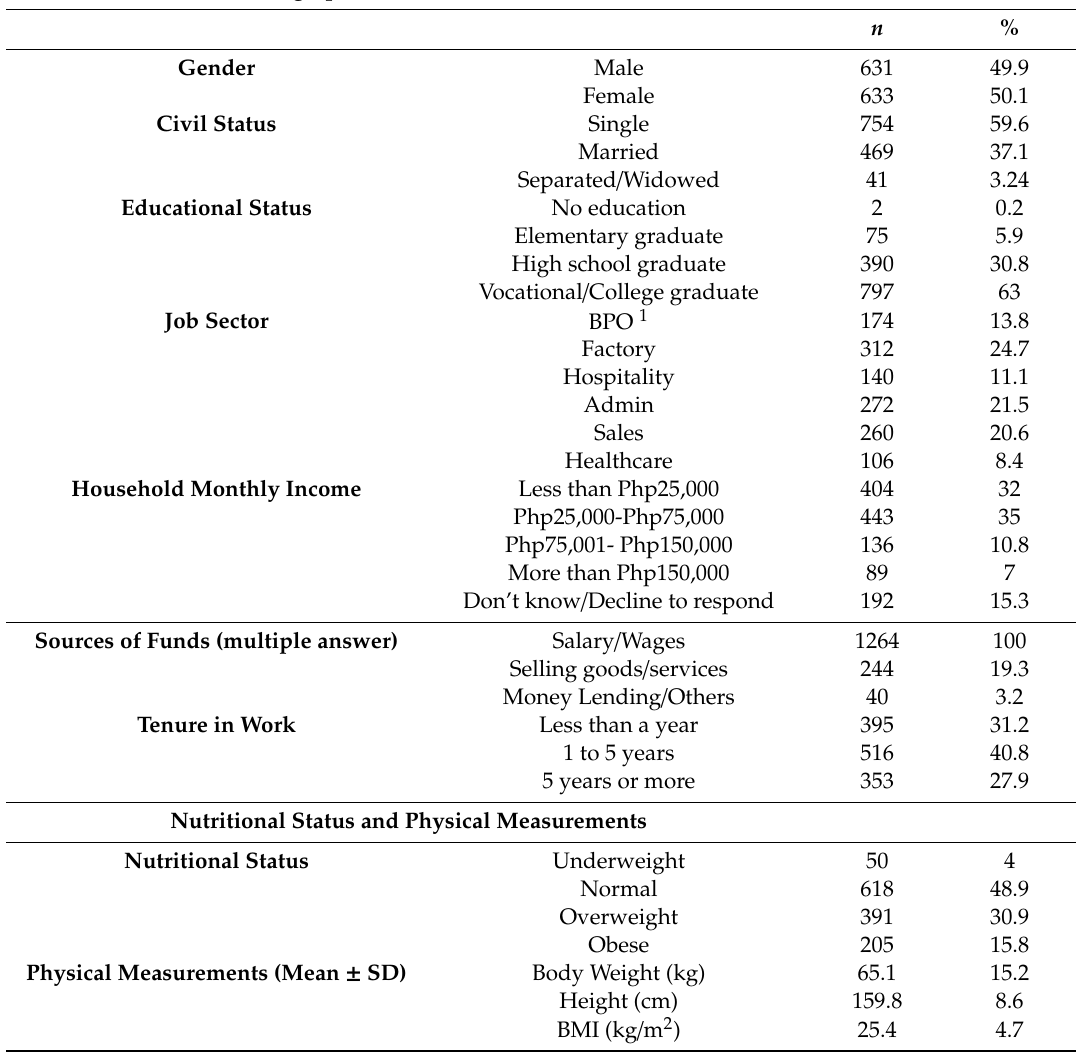
Table 2. Characteristics of the participants ( n =